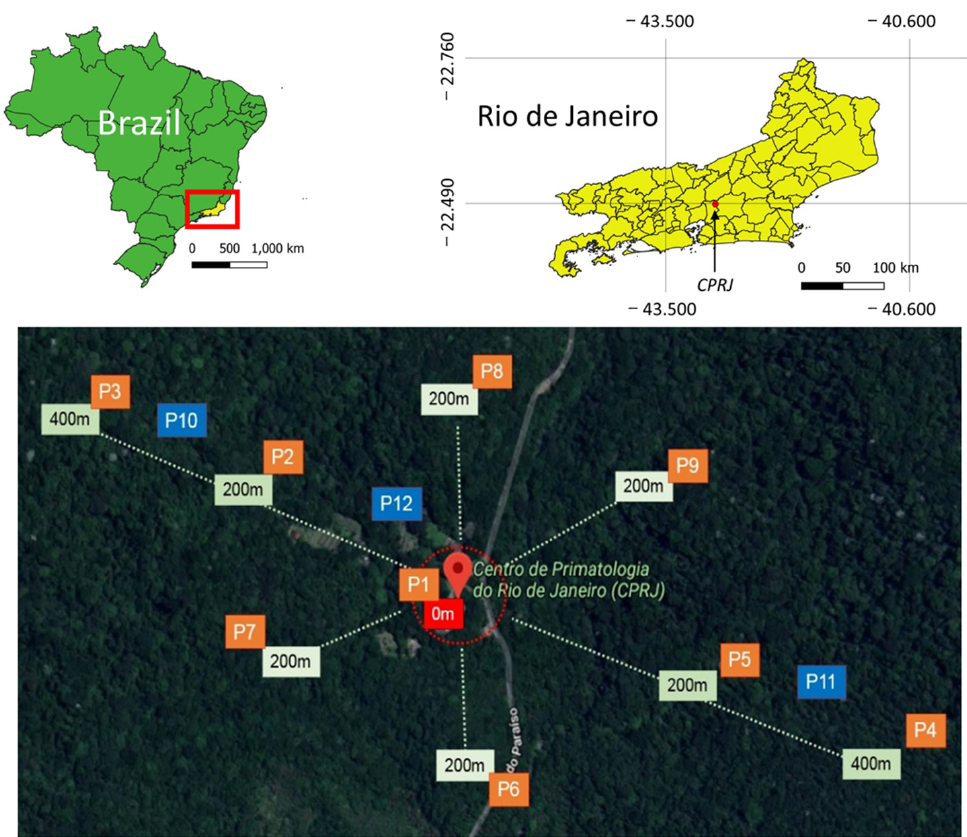
Figure 1. Arrangement of mosquito sampling sites in the Centro de Primatologia do Rio de Janeiro, Rio de Janeiro state, Brazil. The maps were prepared using QGIS 3.14.16 software and edited in Adobe Photoshop CS5. Reprinted from QGIS 3.14.16, a program under a CC BY license, with permission from Jeronimo Alencar—Fiocruz, original copyright 2022.